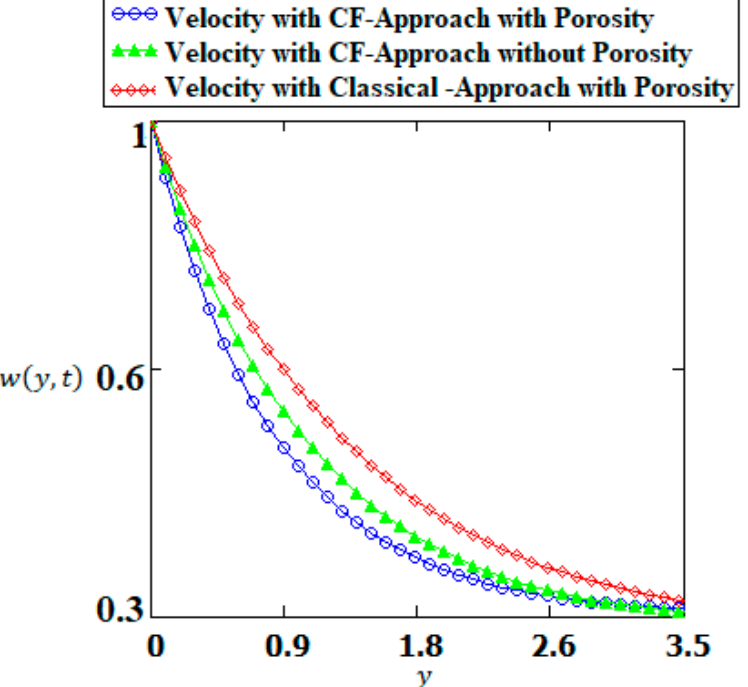
Figure 7. Comparison of velocity field depicted from Equation (19) with Φ = 0 and δ (cid:54) = 1, Equation (19) for Φ (cid:54) = 0 and δ (cid:54) = 1, Equation (19) for Φ (cid:54) = 0 and δ = 1 .